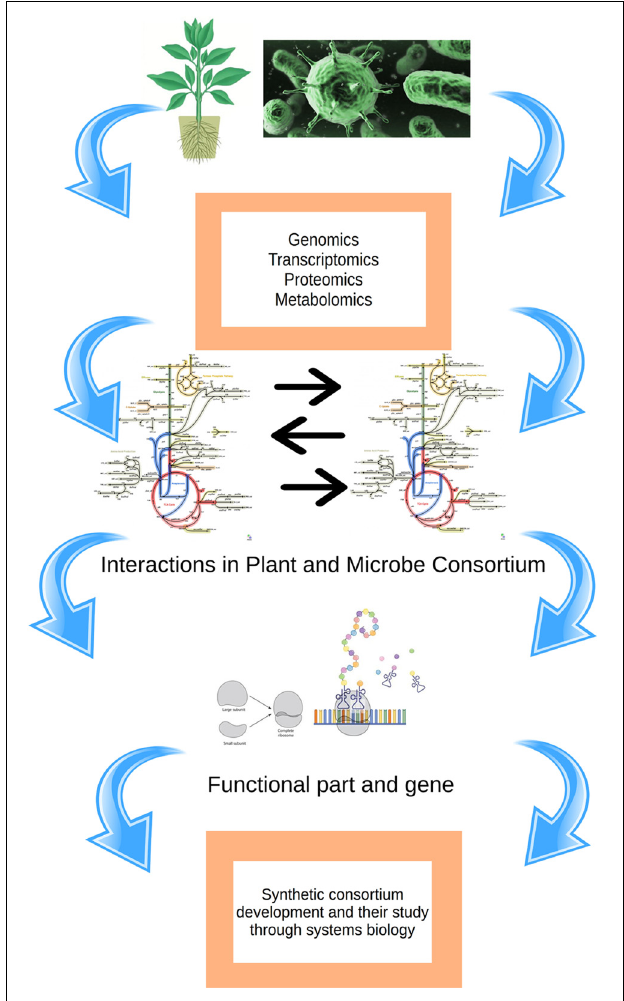
FIGURE 4 | An overview of the prerequisite for understanding plant–microbe interaction through systems